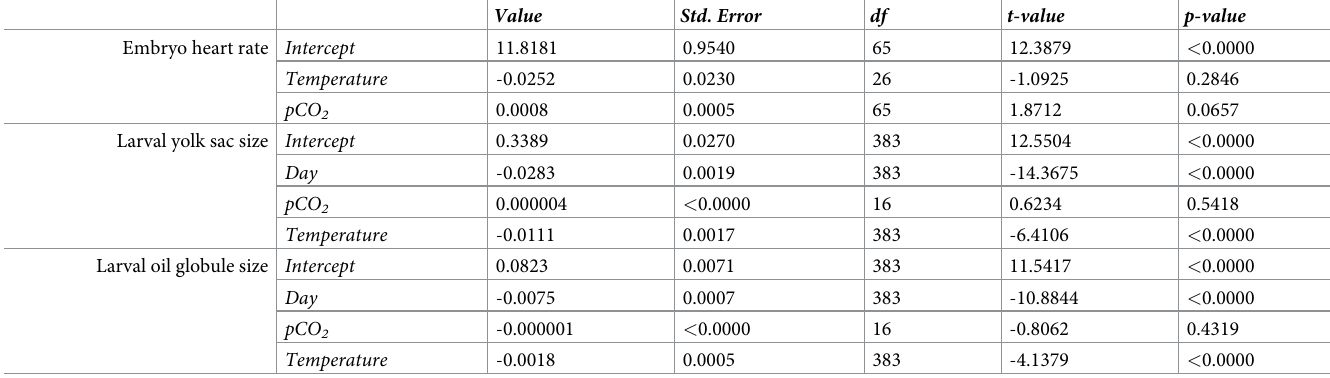
Fig 1. Embryo yolk usage. Proportion of yolk area to total egg area (Y:E) of surf smelt embryos (n = 216/day) that were submerged in treatment water for 13 days. Each point is an average measurement representative of the temperature treatment, p CO 2 treatment (points offset for visualization), and day with standard error shown as whiskers. Day, p CO 2 and Temperature were significant factors predicting embryo yolk usage. https://doi.org/10.1371/journal.pone.0270491.g001 elevated p CO on Y:E (Table 2). Embryo heart rates were not significantly affected by tempera- 2 ture or p CO stressors (Table 3). Surf smelt embryo heart rates in ambient temperature treat- 2 ments were similar between p CO treatments. As temperature increased, the average heartrate 2 increased between 13˚C and 18˚C at elevated p CO and a decreased at ambient p CO but vari- 2 2 ability was high, and these patterns were not significant (S1 Fig). Larvae yolk and oil globule usage Larval yolk size decreased over time in all treatments with day having a significant negative effect on larval yolk size (Table 3; Fig 2). Temperature also had a significant, negative effect on Table 3. Linear mixed effect model